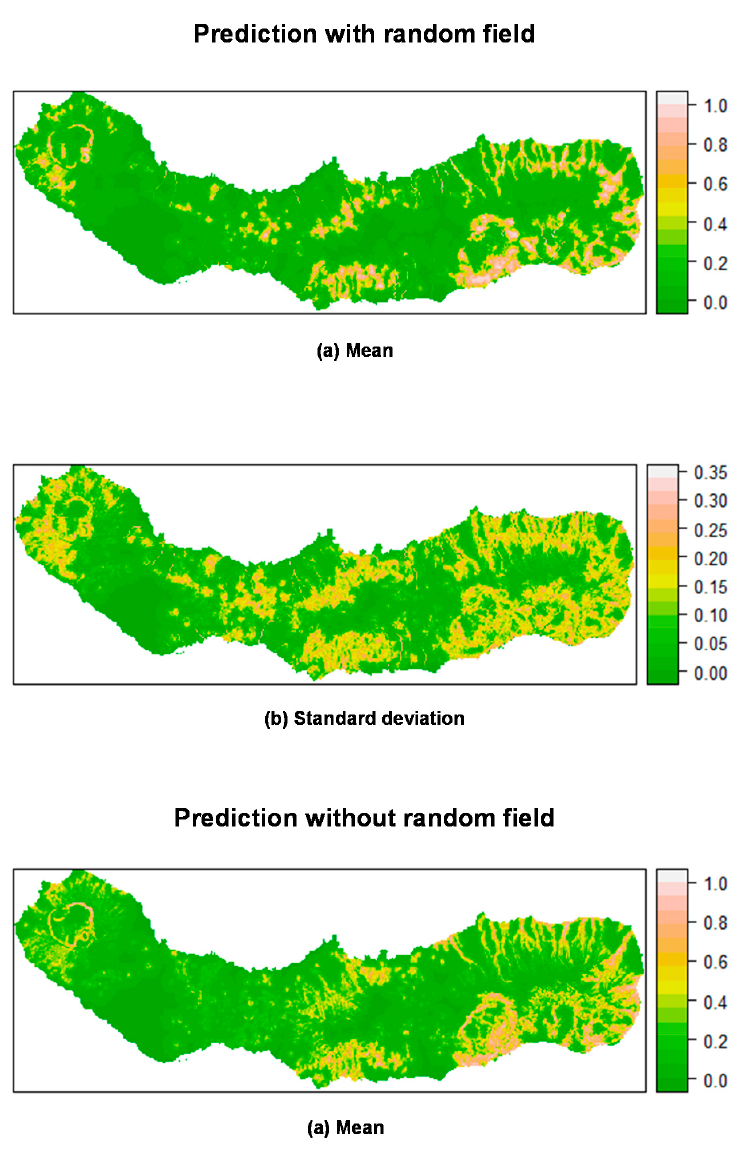
Figure 6. Prediction of M. faya occurrence in Pico Island by posterior mean ( a ) and standard deviation ( b ) of the linear predictor. Top: Mixed effects model including a random field; Bottom: Fixed effects model (without a random field). All models calculated using INLA.